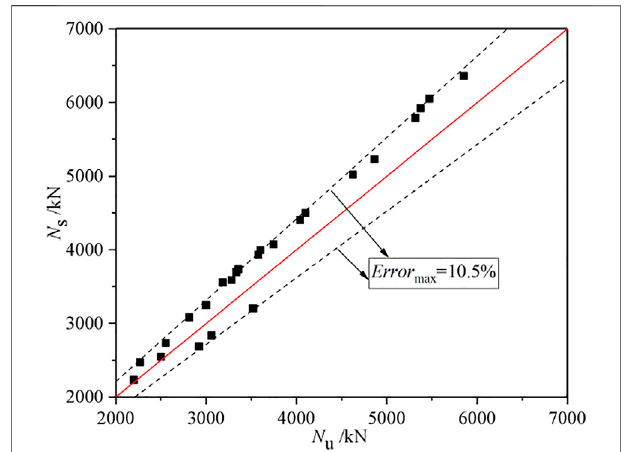
FIGURE16| Comparisonsofsimulatedandcalculatedbearingcapacity of DSTC composite columns.